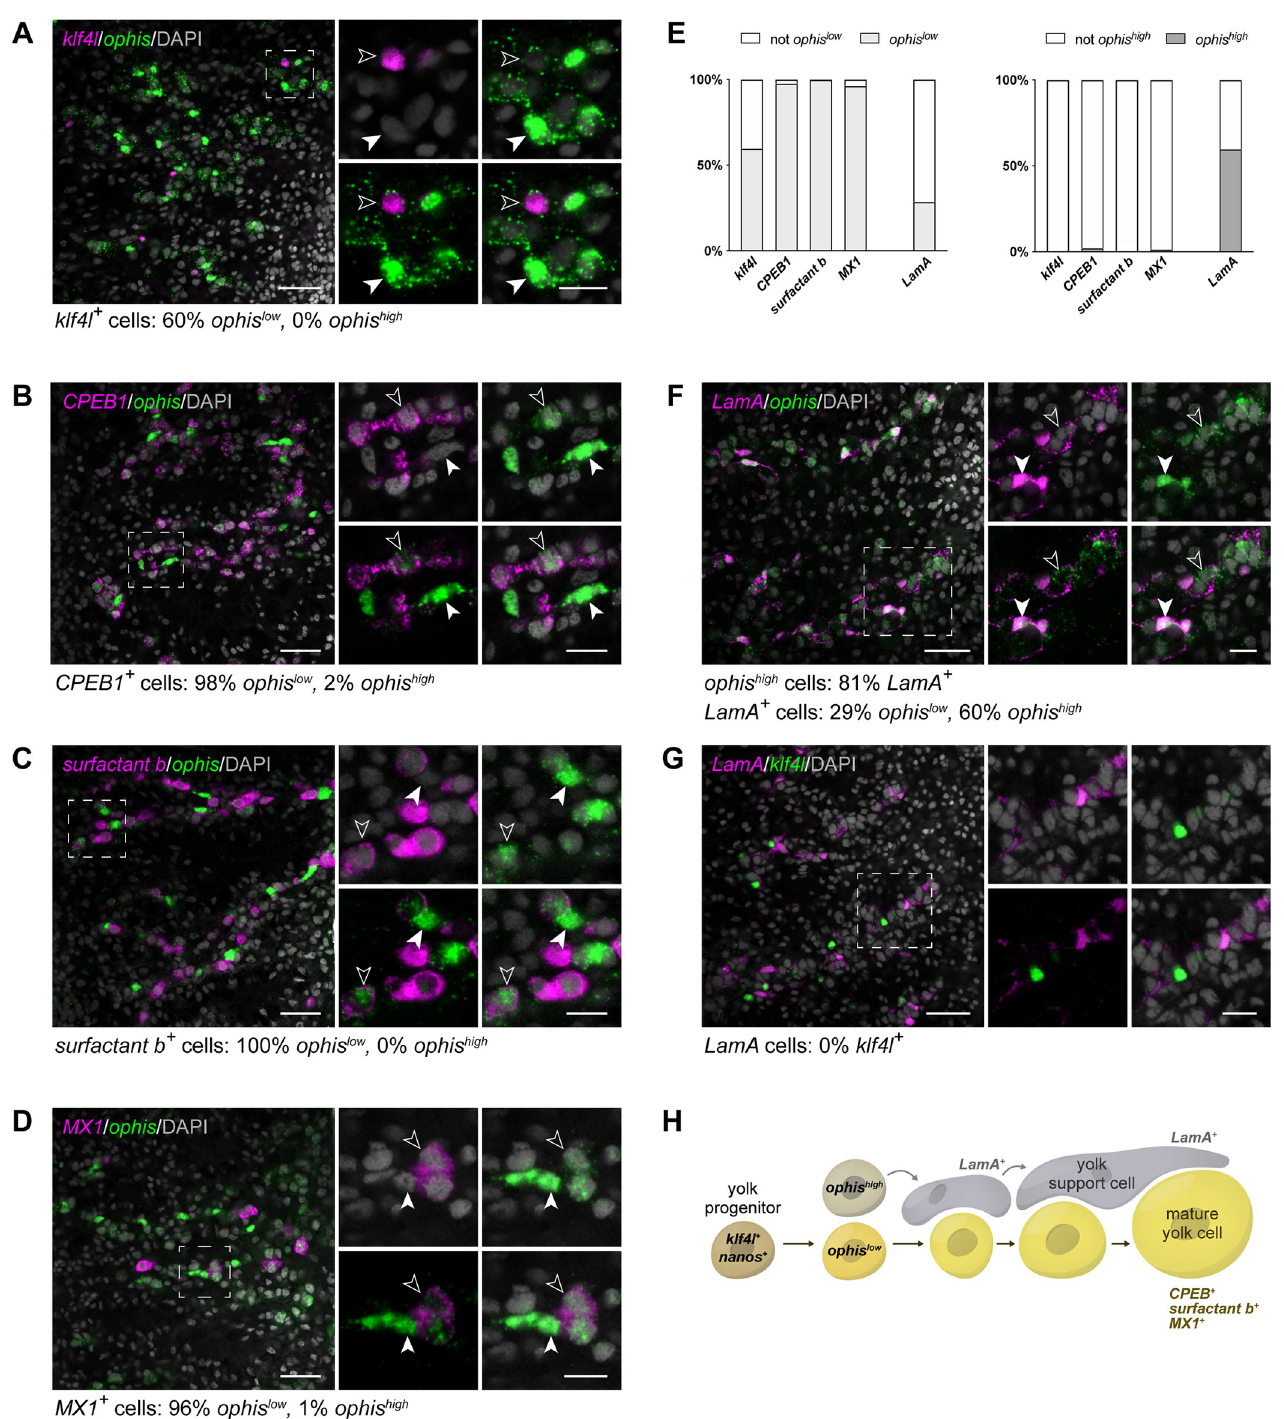
Fig 7. Vitellaria contain distinct cell types: Yolk cells and nonyolk support cells. ( A–D, F–G ) Single confocal sections showing dFISH. Side panels are high- magnification views of outlined areas. ( A ) dFISH of klf4l (magenta) and vitellaria marker ophis (green). ophis high cells do not coexpress klf4l (filled white arrowhead) but ophis low cells do (unfilled white arrowhead). ( B-D ) dFISH of ophis (green) and CPEB1 ( B ), surfactant b ( C ), and MX1 ( D ) (magenta). ophis low cells (unfilled white arrowheads), but not ophis high cells (filled white arrowheads), express yolk cell lineage differentiation markers. ( E ) proportion of cells in the vitellaria that coexpress low levels (left) versus high levels (right) of ophis . ophis low cells predominantly coexpress markers of the yolk cell lineage. Conversely, most ophis high cells coexpress LamA but do not express yolk cell markers. ( F ) dFISH of LamA (magenta) and ophis (green). ophis high cells coexpress LamA (filled white arrowhead) whereas ophis low cells do not (unfilled white arrowhead). ( G ) dFISH of LamA (magenta) and klf4l (green). LamA and klf4l are